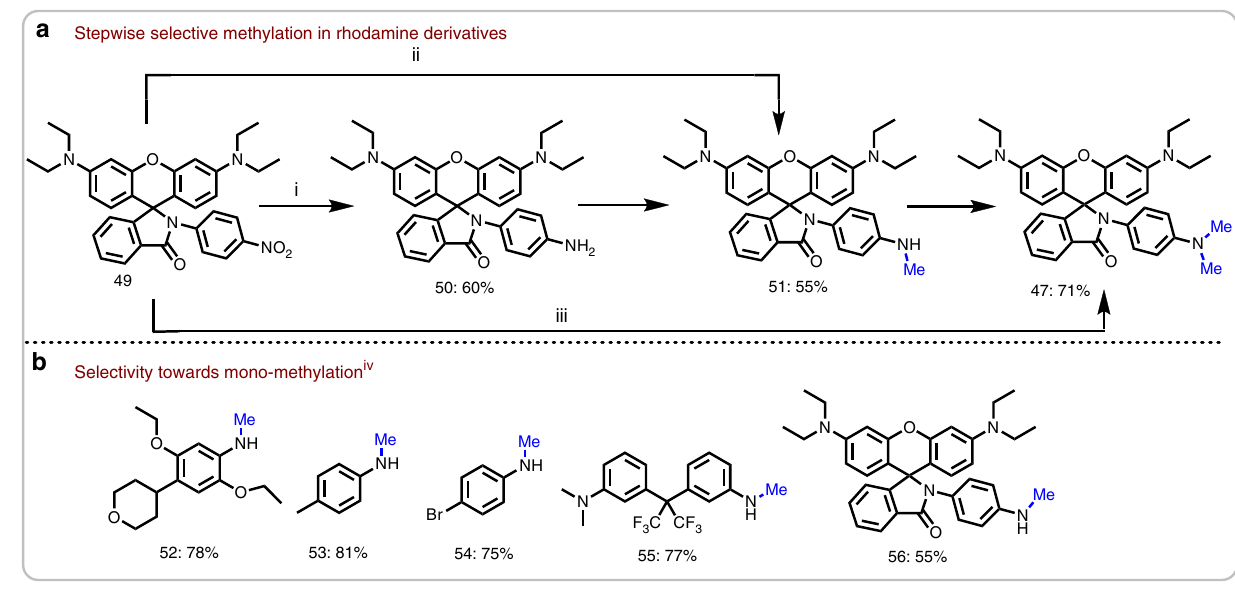
Fig. 5 Controlled stepwise reductive methylation. a Example showing fl uorescent compound i, ii, iii . b Selectivity towards mono-methylation iv . a Reaction conditions a : i 0.5 mmol of 49, 50 mg Fe 2 O 3 /NGr@C (5 mol% Fe), 2 mmol paraformaldehyde, 1 mmol Na 2 CO 3 , 2 mL DMSO-water (1:1), 130 °C, 8 h. ( b ): ii 0.5 mmol of 49, 50 mg Fe 2 O 3 /NGr@C (5 mol% Fe), 3.2 mmol paraformaldehyde, 1 mmol Na 2 CO 3 , 2 mL DMSO-water (1:1), 130 °C, 18 h.